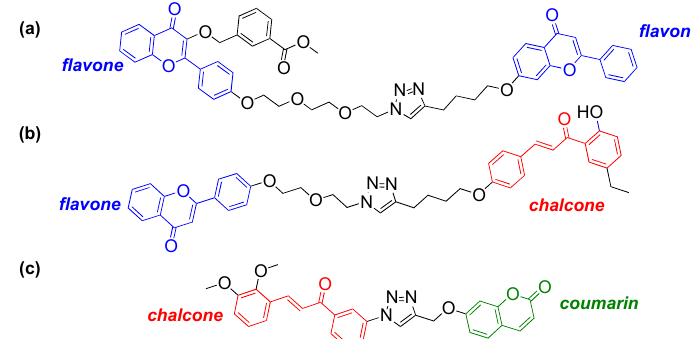
Figure 1. Three examples of biologically active triazole-linked flavonoid dimers. The flavonoid subunits in each example are highlighted in colours. ( a ) A modulator of multidrug resistance in some cancers [10]; ( b ) A modulator of multidrug resistance in some cancers [10]; ( c ) A compound with anticancer activity and antimalarial activity [11].